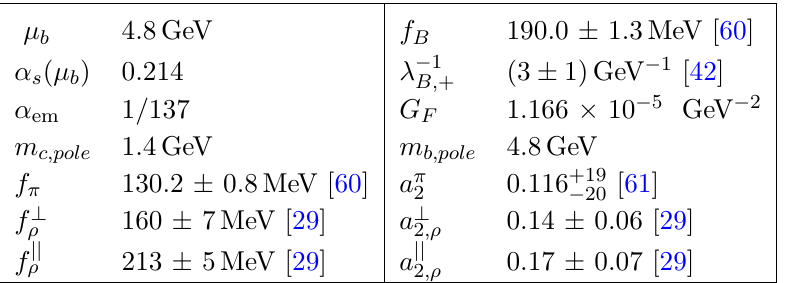
Table 4 . Inputs used in the